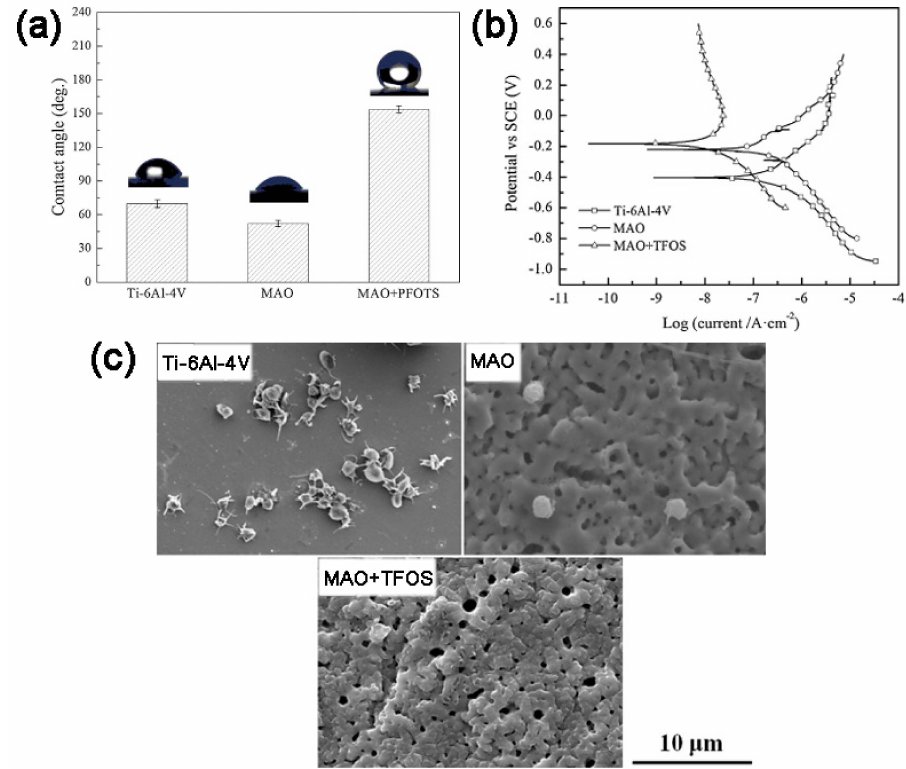
Figure 10. ( a , b ) Variations on contact angles and potentiodynamic polarization curves of the Ti-6Al-4V, MAO and MAO + PFOTS samples; ( c ) The morphologies of platelets adhered on the surface of the obtained samples. Reprinted from [77], Copyright (2015), with permission from